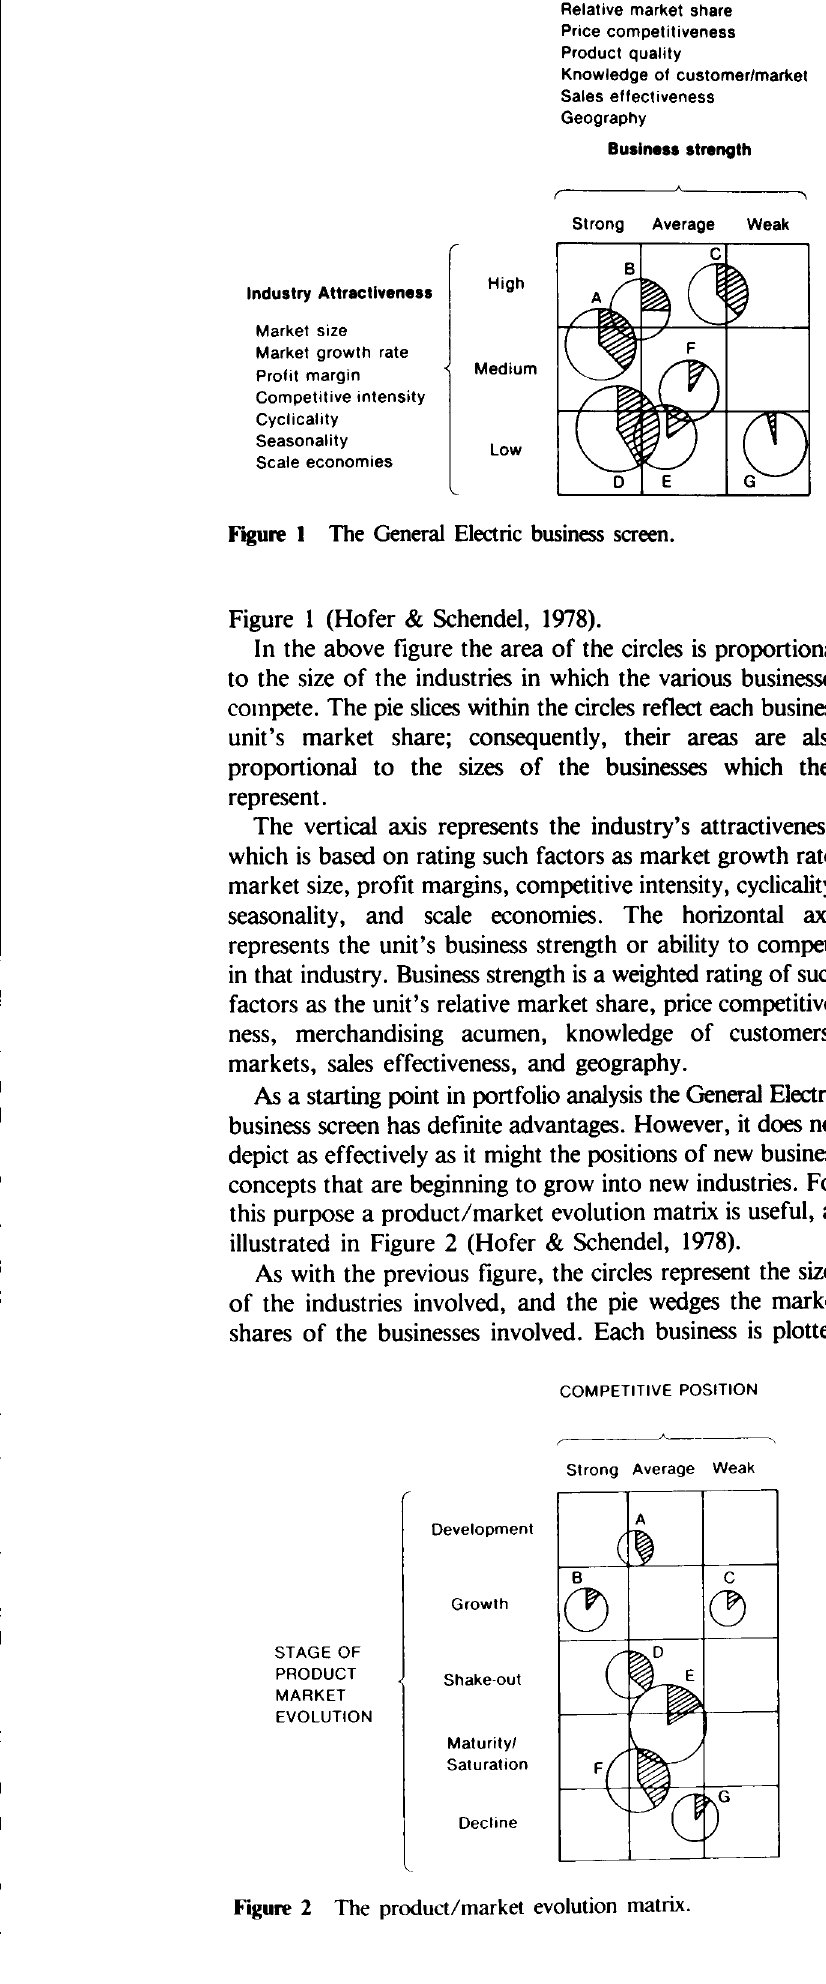
Figure 2 The product/market evolution